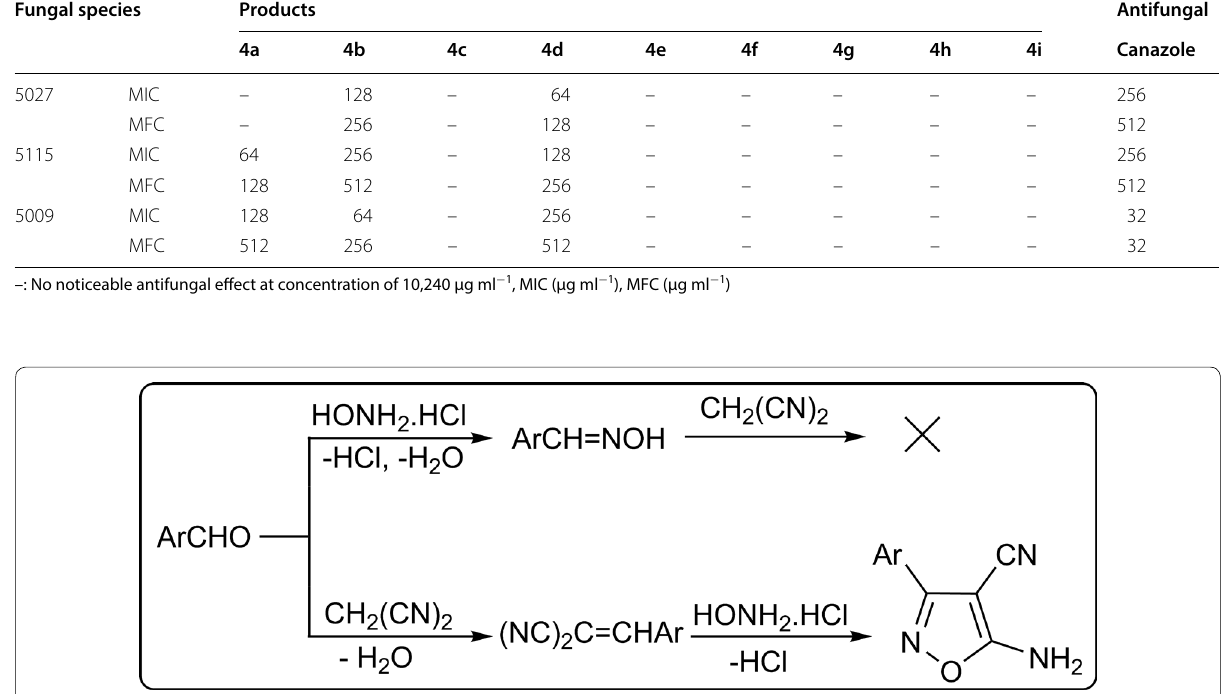
Table 2 Antifungal effects of isoxazoles 4a–i Fungal species